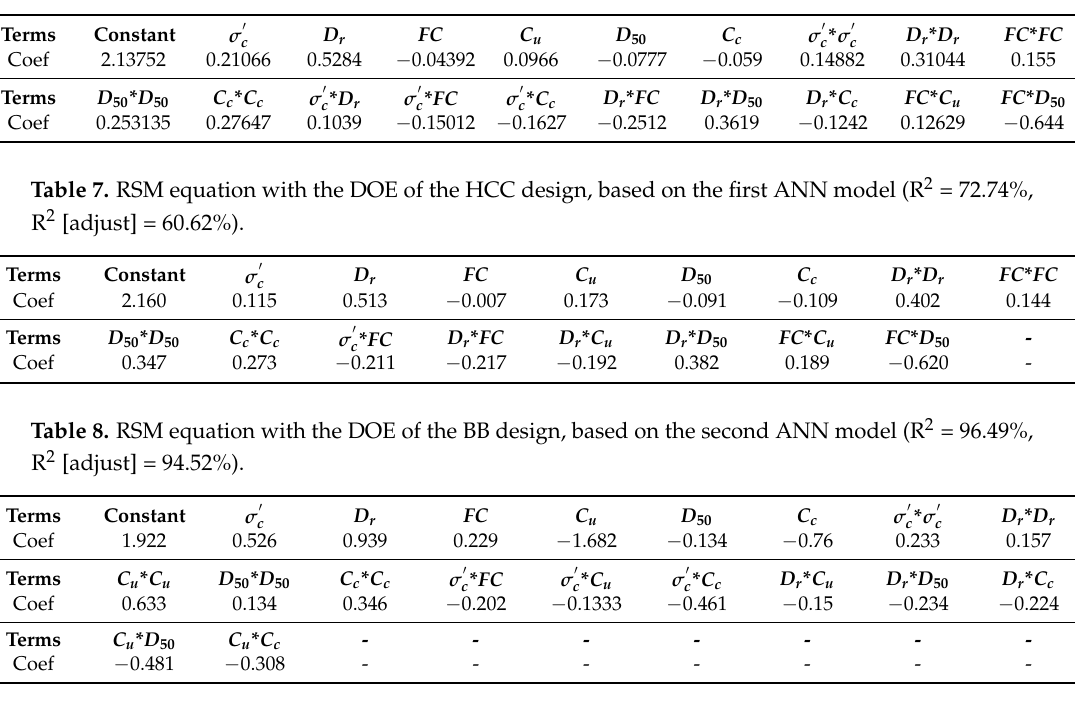
Table 6. RSM equation with the DOE of the CC design, based on the first ANN model (R 2 = 73.89%, R 2 [adjust] = 66.81%).